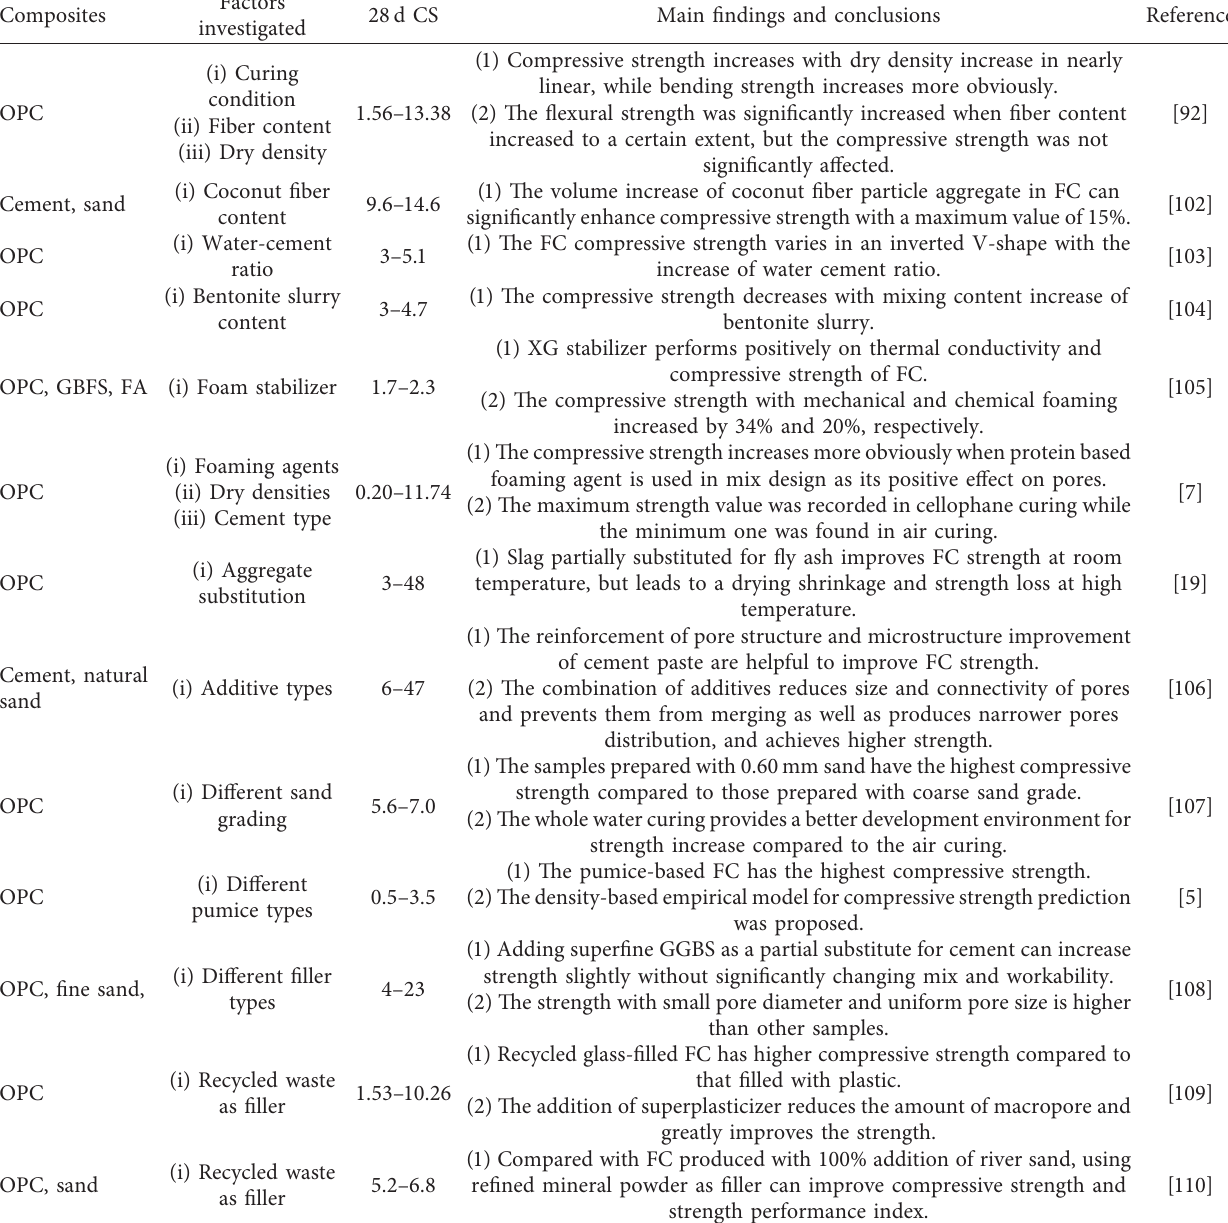
Table 3: Overview on research on factors affecting compressive strength of